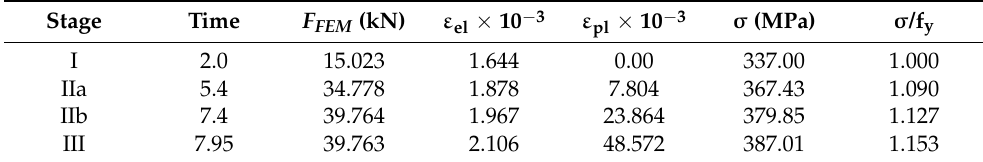
Table 6. Threshold values: shells’ behaviour.